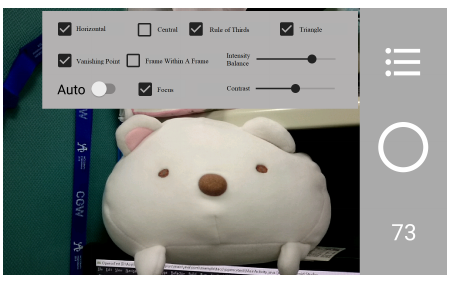
Figure 1. Some interface of our